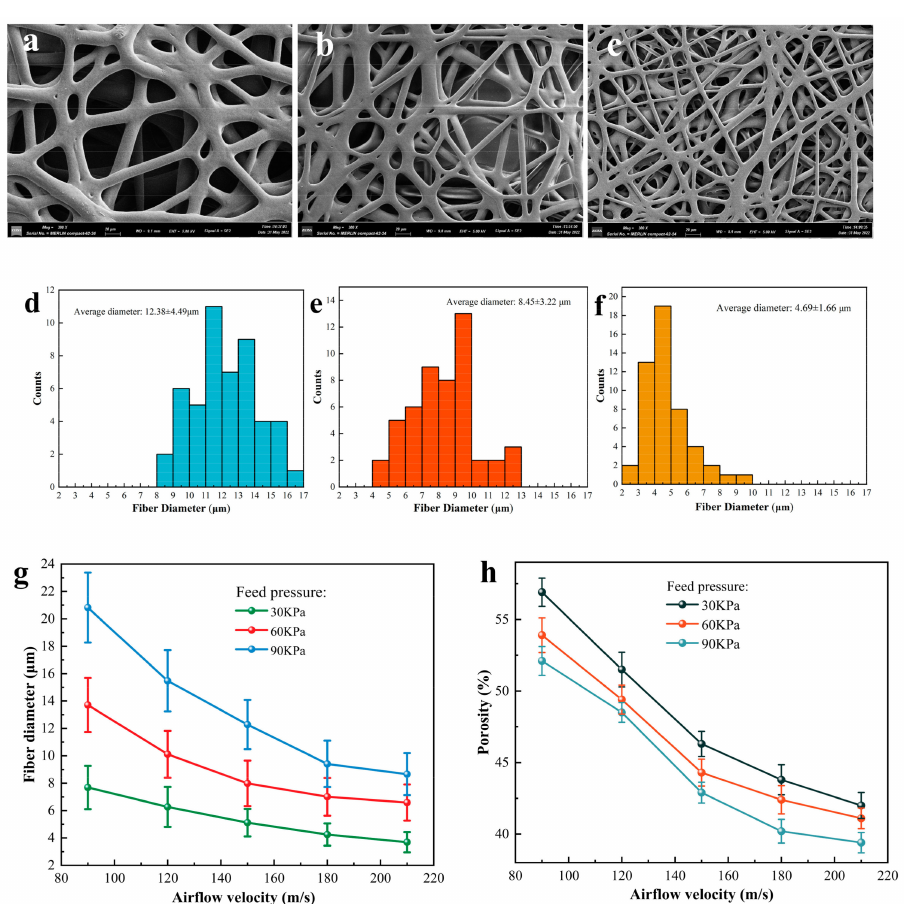
Figure 5. ( a – c ) Microscopic images of fibers corresponding to different printing parameters, at the same magnification. ( d – f ) Statistical diagram of fiber diameter. ( g ) Relationship between printing parameters and fiber diameter. ( h ) Relationship between printing parameters and fiber porosity. The porosity of the fiber was measured using threshold segmentation of SEM images, where the dark color represented the background and the light color indicated the